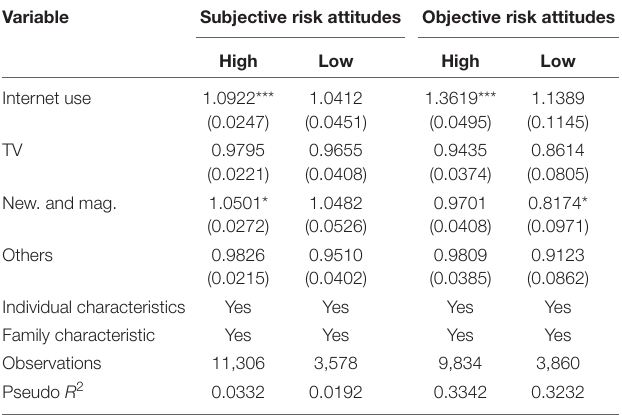
TABLE 6 | Grouped by the using frequency for